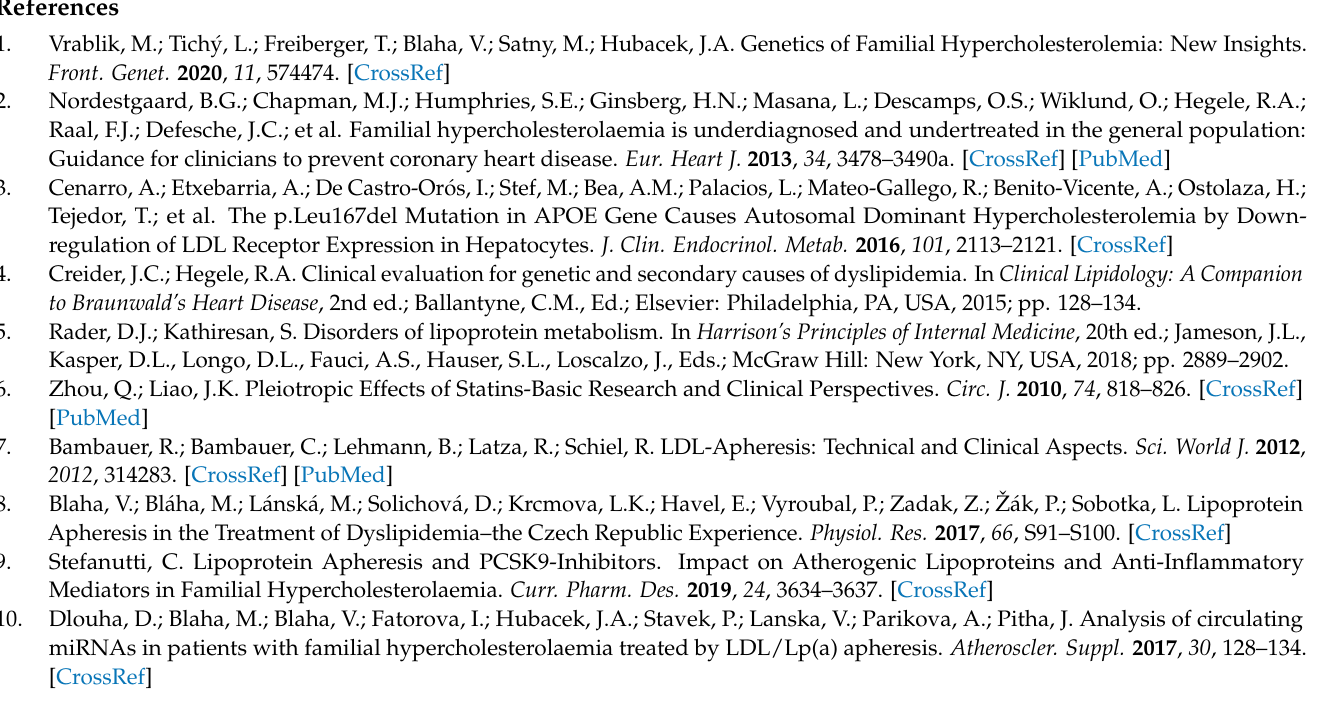
Table S2: Comparison of LDLR protein concentration between LDLR heterozygotes vs. homozygotes. Table S3: Plasma lipid level changes with respect to treatment. Table S4: Classification of protein biomarkers according to biological